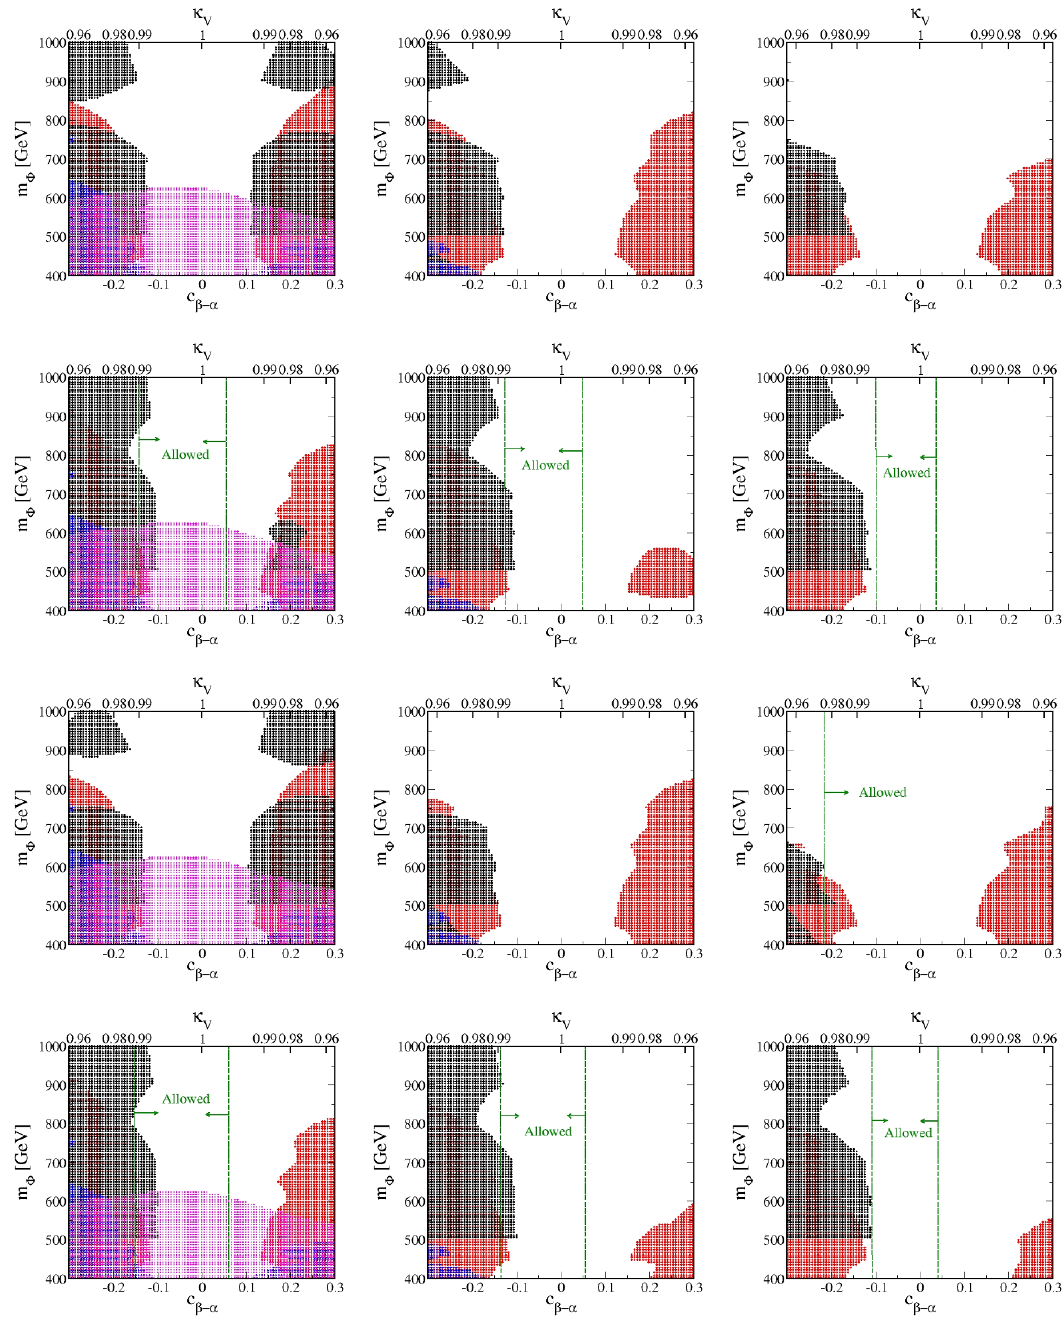
Figure 7 . Constraints on the parameter space with M/m Φ = 1 in the 2HDMs, where tan β is taken to be 1 (left), 2 (center) and 3 (right). The top to bottom panels show the results in the Type-I, -II, -X and -Y 2HDMs. The shaded regions are excluded by the direct searches at the LHC: gg H hh (black), gg A Zh (red), gg H ZZ (blue), and gg H/A t ¯ t → → → → → → → → (magenta). The region outside the green dashed curves is excluded by the 95% CL Higgs signal strength